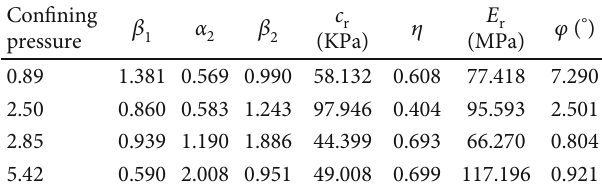
Table 3: The results of unknown parameters by back analysis.